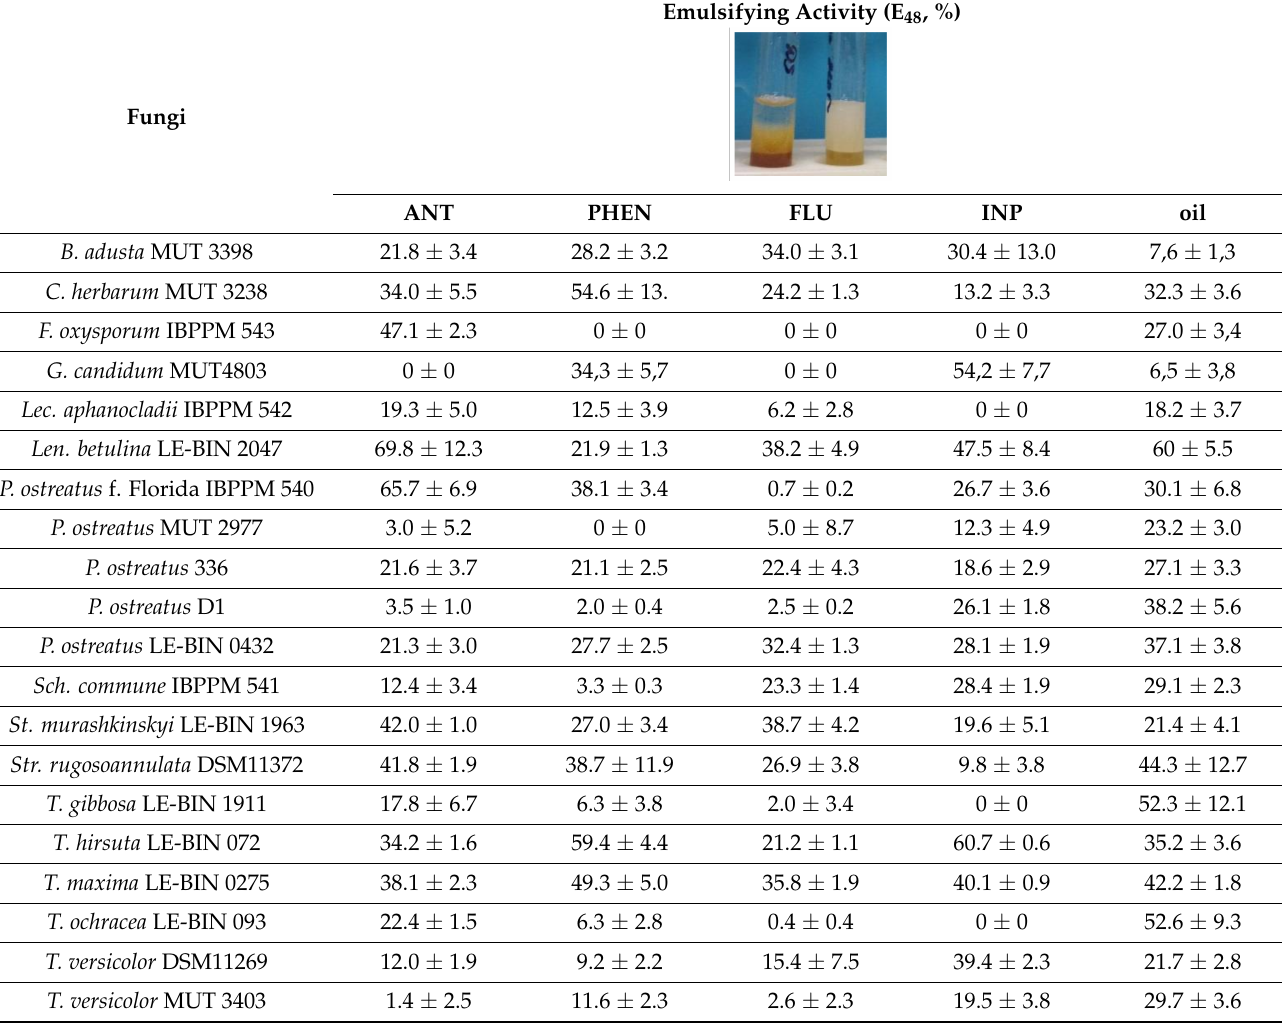
Table 3. Emulsifying activities of cultivation medium after growth of studied fungi in the presence of hydrophobic pollutants (E 48 ,